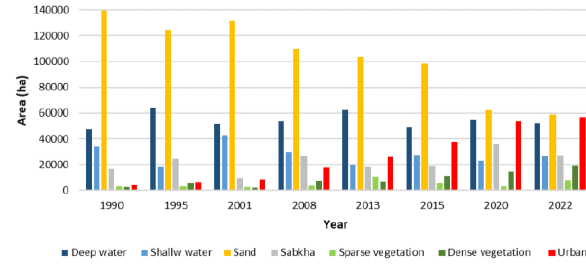
Figure 4: LULC maps in Abu Dhabi from 1990 to 2022. Figure 4 demonstrates the gradual change in land cover from 1990 to 2022, with a decrease in sand coverage and an increase in urban coverage. The scope of this paper is to find the urban growth in the study area, hence, to enhance the clarity of change between urban and non-urban class binary mask was applied. The use of a binary urban/non-urban mask provided a simple, yet useful, representation of the urban-rural dichotomy. Figure 5 presents the binary maps with urban and non-urban class between 1990 and 2022. population. The statistical data shows a rising trend in population, and urbanization follows the same trend as displayed in Figure 6. Urban sprawl and population growth of AD are showing significant rise between the years 1990 and